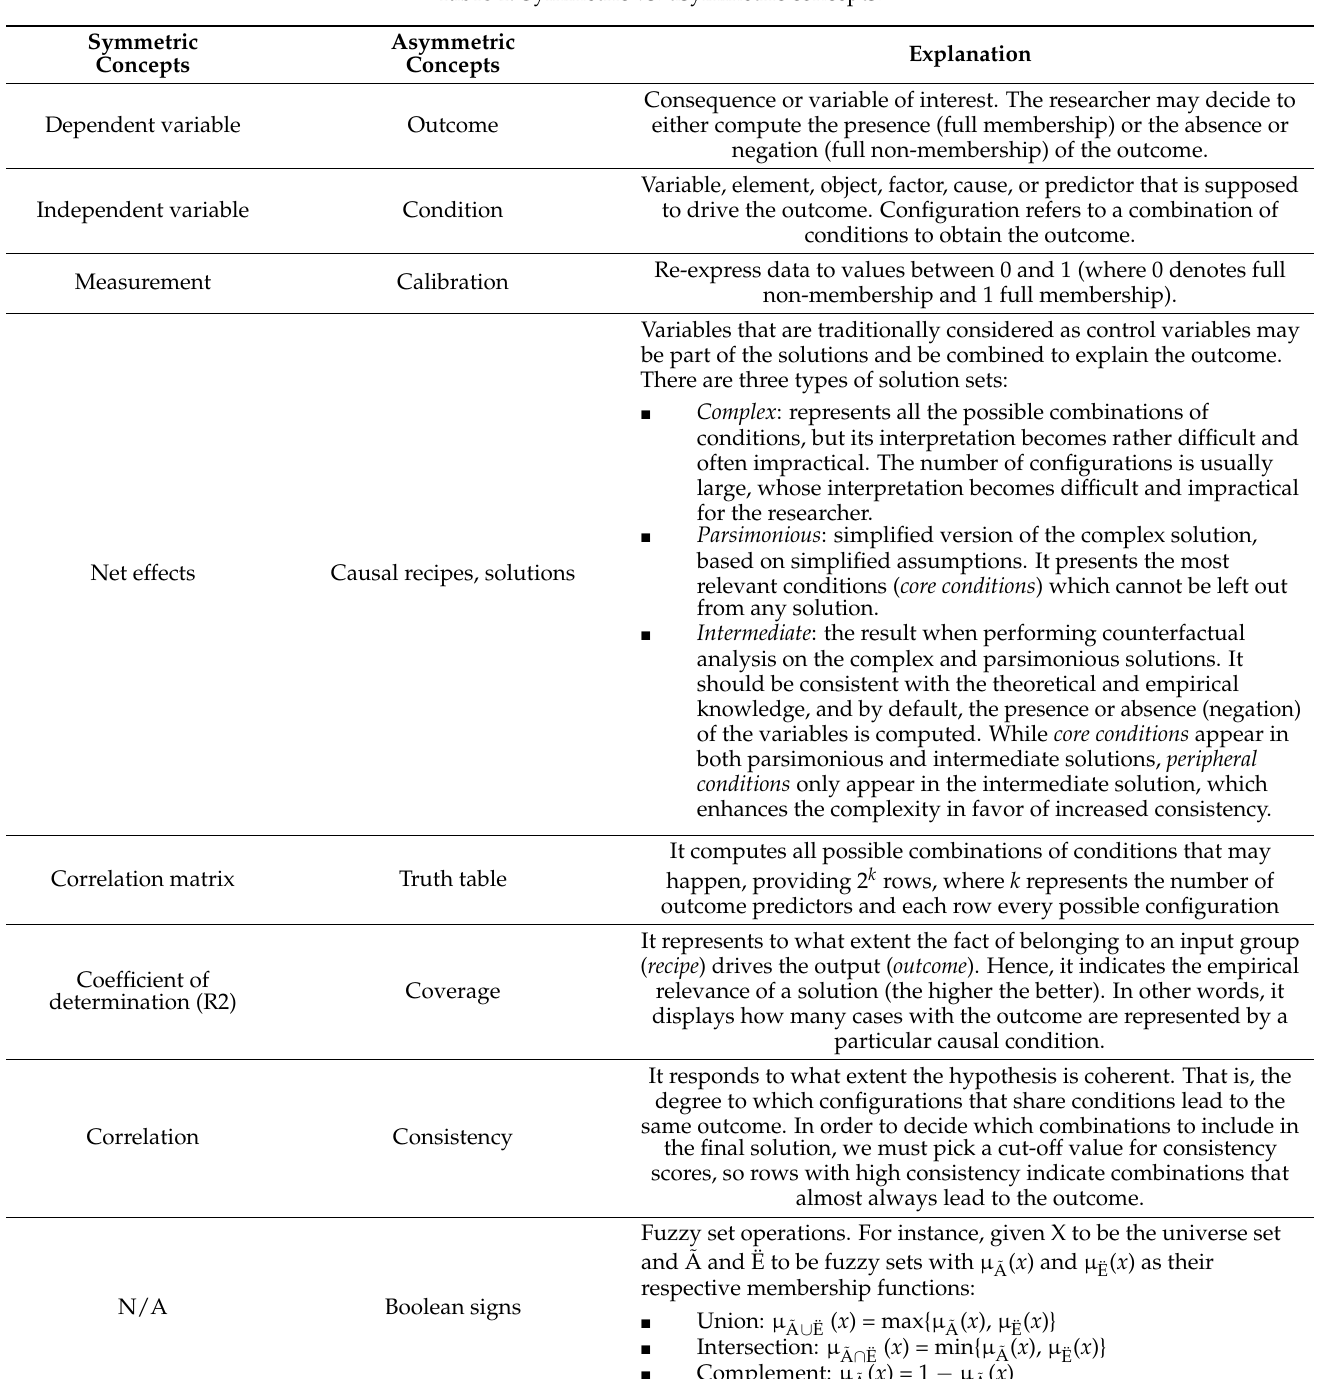
Table 1. Symmetric vs. asymmetric